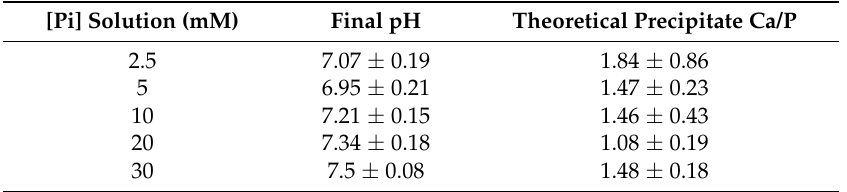
Table 4. Summary of pH and theoretical Ca/P results for the batch, unseeded precipitation